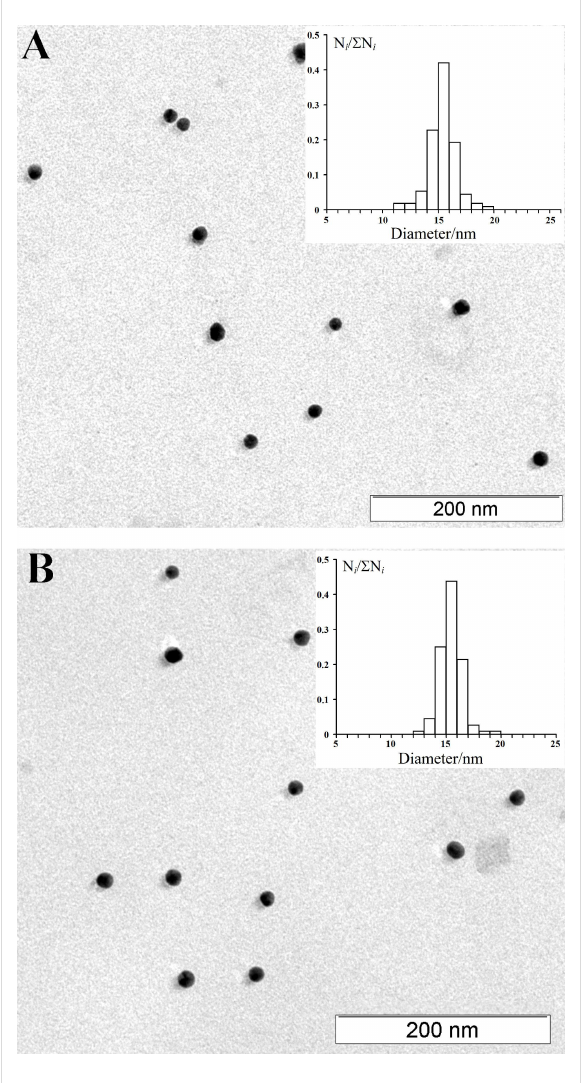
Figure 2: Transmission electron microscopy (TEM) images of Ara 6 - GNPs 3 (A) and 4 (B). The insets show size distribution diagrams with 15 nm average diameter in both